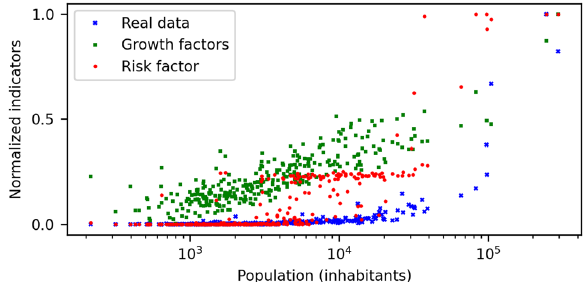
Figure 6. Comparative of three different normalized indicators for the municipality nodes. The figure plots the normalized cumulative incidence data (blue), risk factors (red) and growth factors (green) versus the municipality population in semi-logarithmic